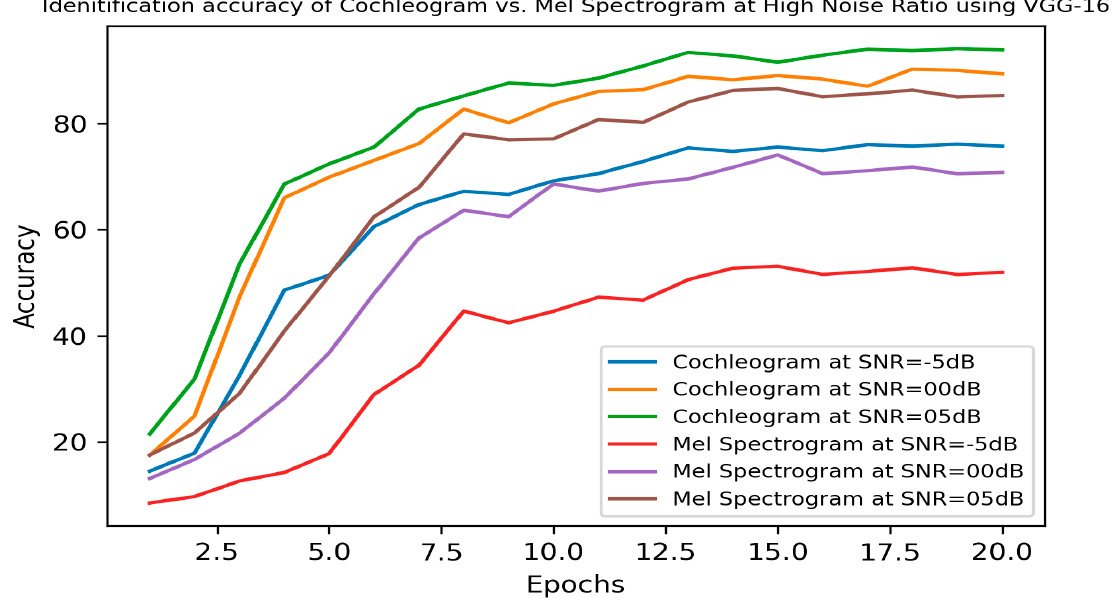
Figure 7. Speaker Identification Accuracy of Cochleogram vs. Mel Spectrogram at Medium Noise Ratio using VGG-16 Architecture.